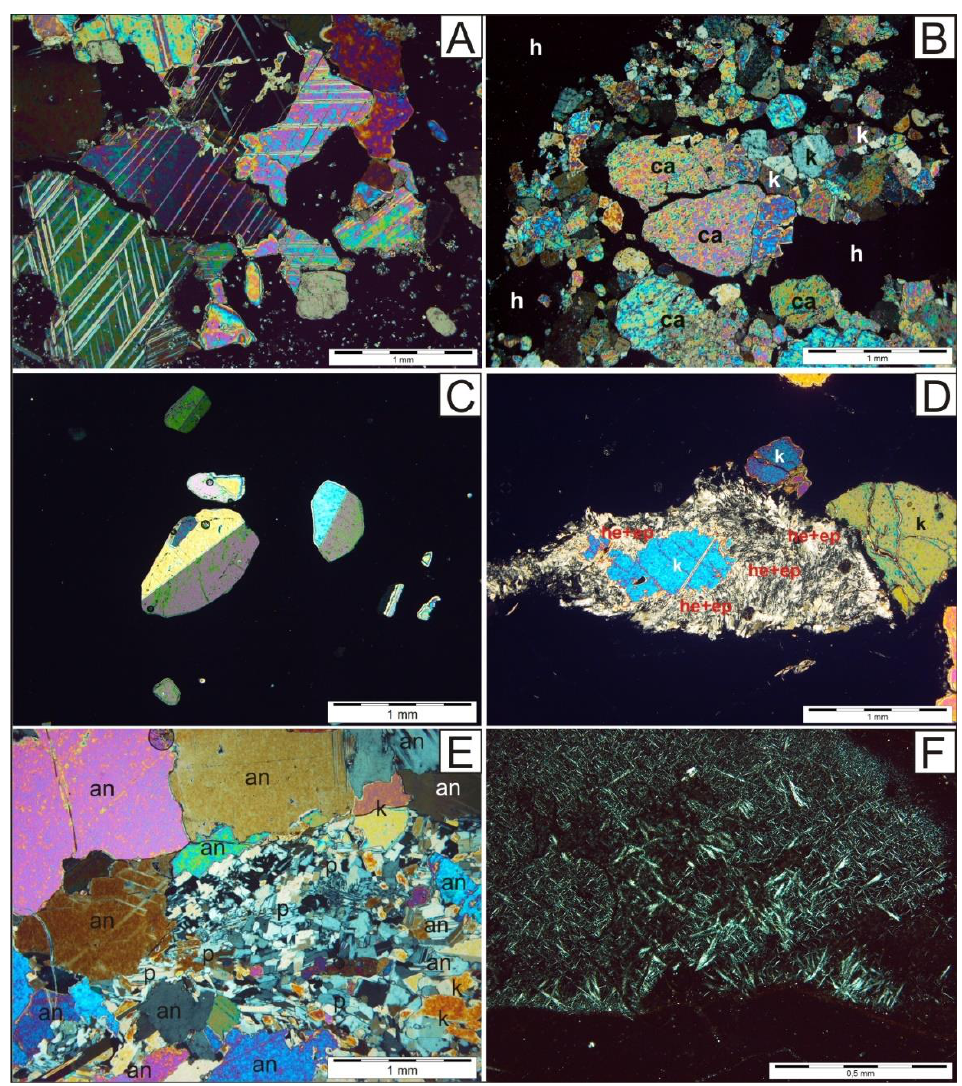
Figure 12. Main minerals of Zechstein potash-bearing deposits (thin sections, X polars). ( A ) Twinned carnallite crystals within halite-sylvite mass (black). Older Potash (K2) unit, Inowrocław salt dome. ( B ) Large carnallite (ca) and fine twinned kieserite (k) crystals within halite (h). Younger Potash (K3) unit, salt mine KŁODAWA S.A., NE-SW gallery, mine level 600 m. ( C ) Twinned kieserite crystals within halite-sylvite mass (black). Older Potash (K2) unit, Damasławek B well, depth 706.5 m. ( D ) Kieserite crystals (k) transformed into hexahydrite and epsomite (he + ep), halite-sylvite background (black). Older Potash (K2) unit, G-42 well, depth 1720 m. ( E ) Fine polyhalite crystals (p) framed by large anhydrite (an) and smaller kieserite (K) ones. Older Potash (K2) unit, M-34 well depth 487 m. ( F ) Needle crystals of bischofite, halite-sylvite background (black). Older Potash (K2) unit, Inowrocław salt